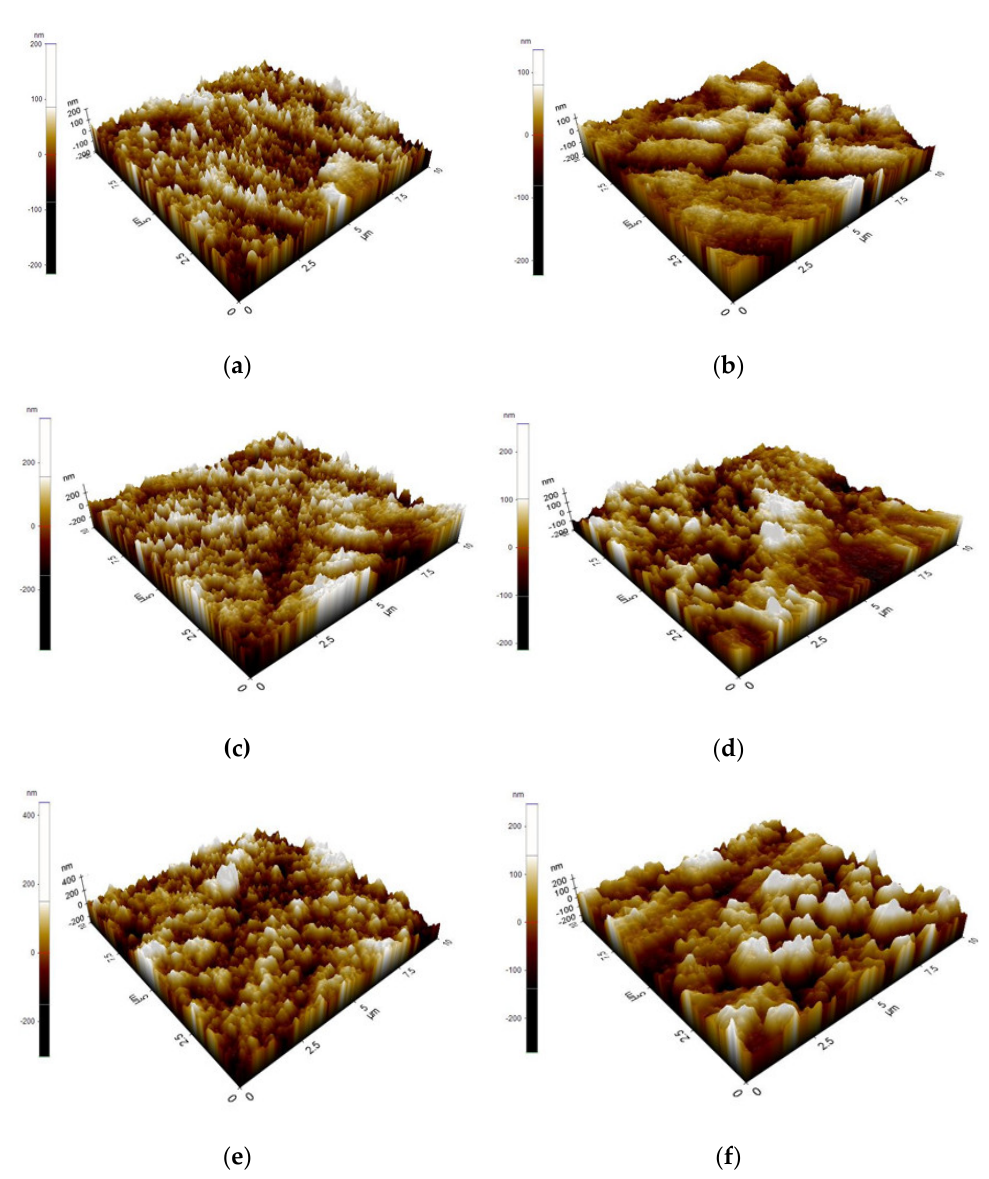
Figure 8. AFM images of the investigated: ( a ) Al/5% B 4 C-5% ZrO 2 , ( b ) Al/15% B 4 C-15% ZrO 2 , ( c ) Al/10% B 4 C-10% ZrO 2 , ( d ) Al/5% B 4 C-15% ZrO 2 , ( e ) Al/15% B 4 C/5% ZrO 2 samples, and ( f )